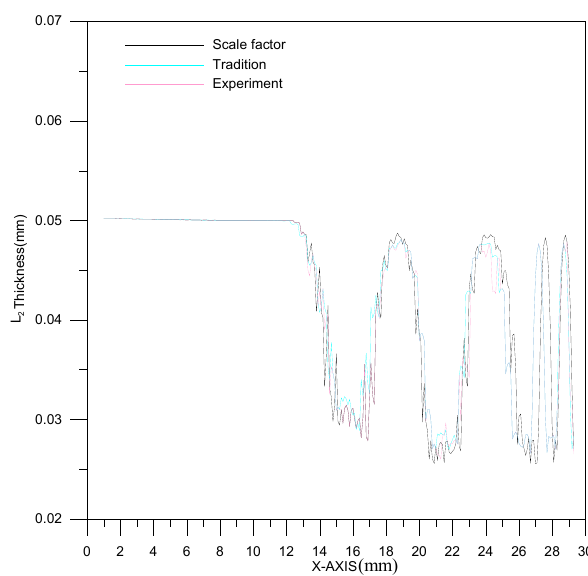
Figure 13. The thickness variation of the L 1 section.